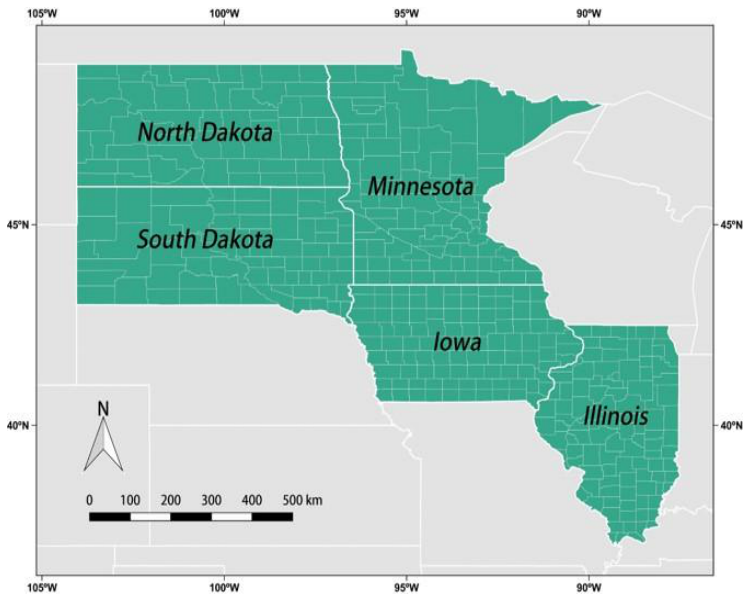
Figure 1. Study area.